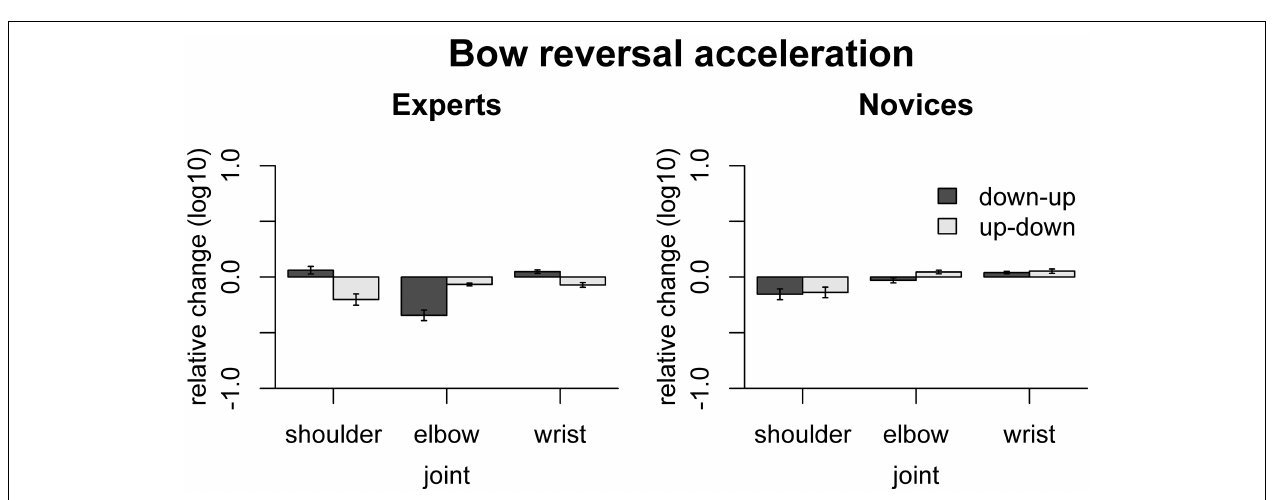
FIGURE 6 | Results of the freezing analysis for bow angle variability. Error bars indicate SE across participants.